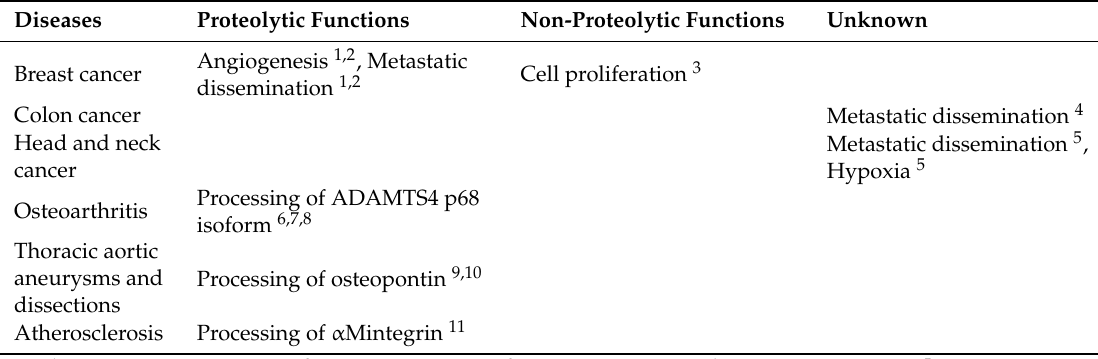
Table 2. Proteolytic and non-proteolytic functions of MT4-MMP in di ff erent